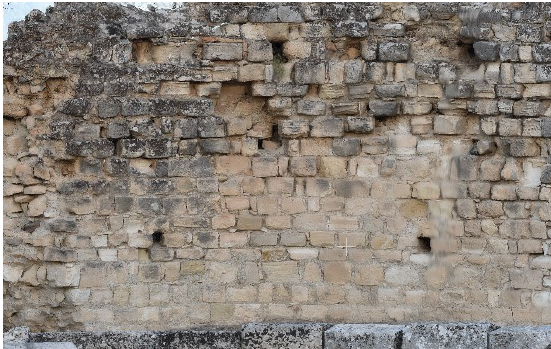
Figure 2. Photogrammetric reconstruction of the exavation area Apollo Temple in Gortyn (Crete).